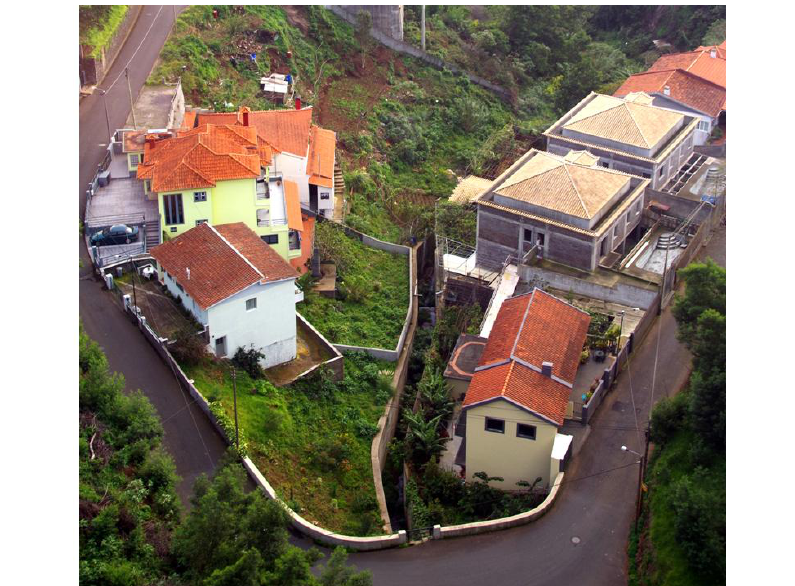
Figure 4b: Neglected river in Funchal, Madeira, Portugal, surrounded by the housing areas. Even the small streams are paved with concrete and put in the deep corridors, which stops the natural migration of animals and prevents the wild plants to grow by the river banks. Such situation is disadvantageous also for people, who can neither make a spontaneous walk along the river nor cross it (compare the theoreti- cal case in Fig.